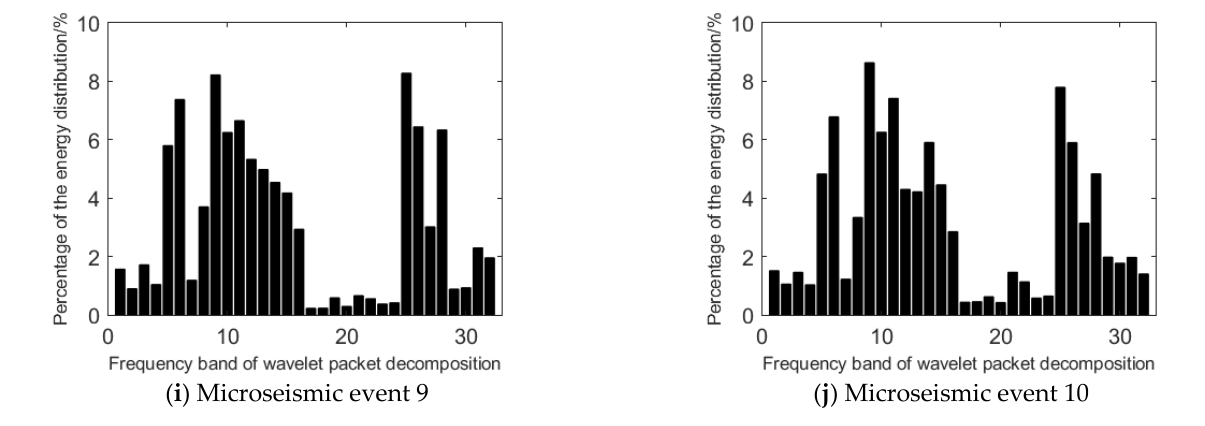
Figure 6. Frequency band energy distribution of microseismic event waveform.